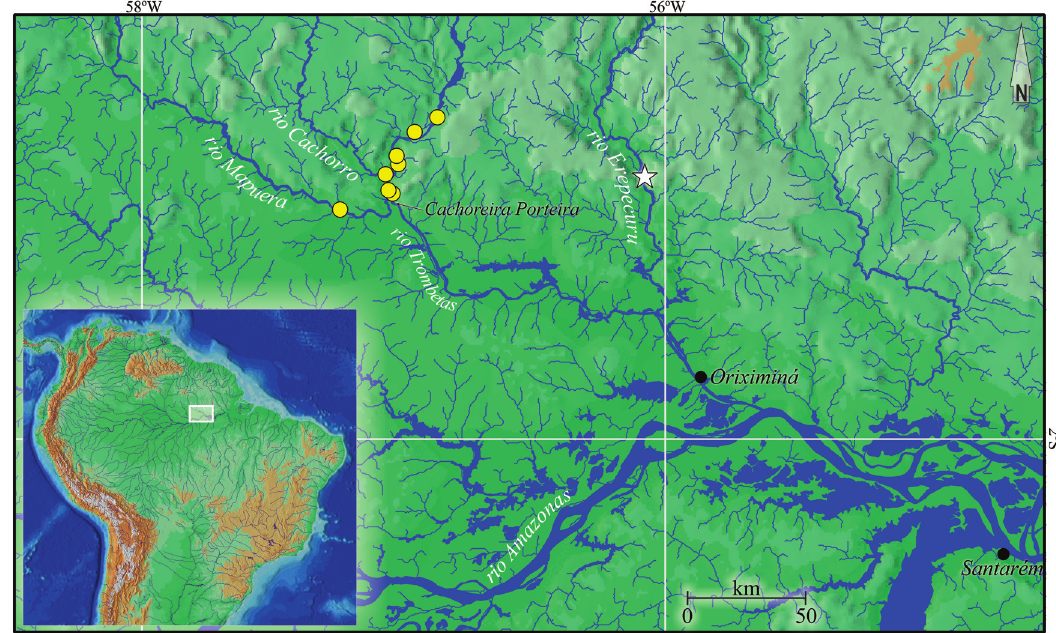
Fig. 4. Map of upper rio Trombetas basin and adjoining areas, showing the distribution of Tometes camunani . Star indicates type